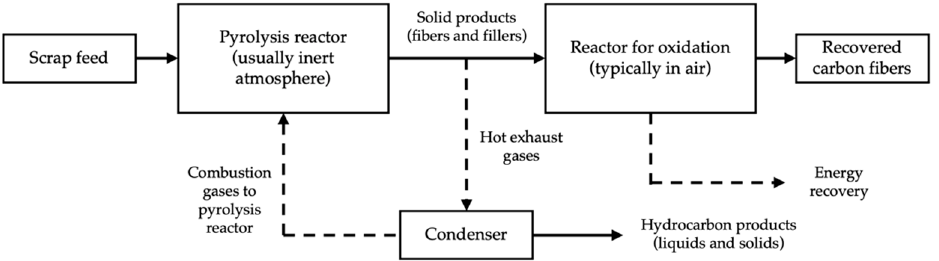
Figure 4. Pyrolysis process (modified from Pickering et al. [63]).